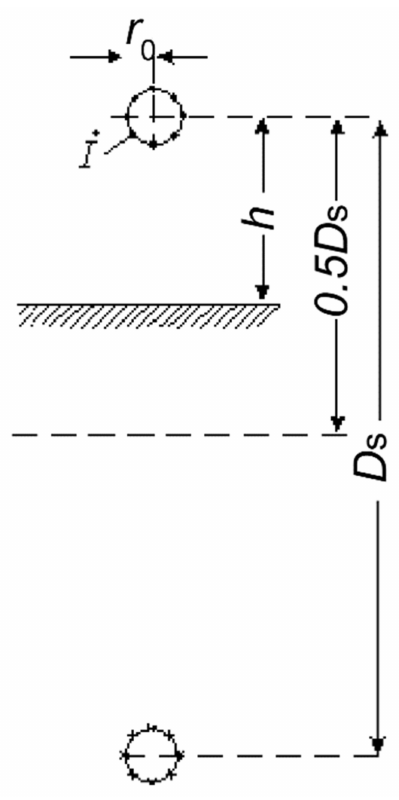
Figure 9. System “line wire—imaginary wire” taking into account the final conductivity of the